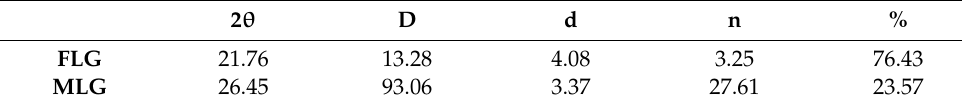
Table 1. The XRD parameters of exf-NGr